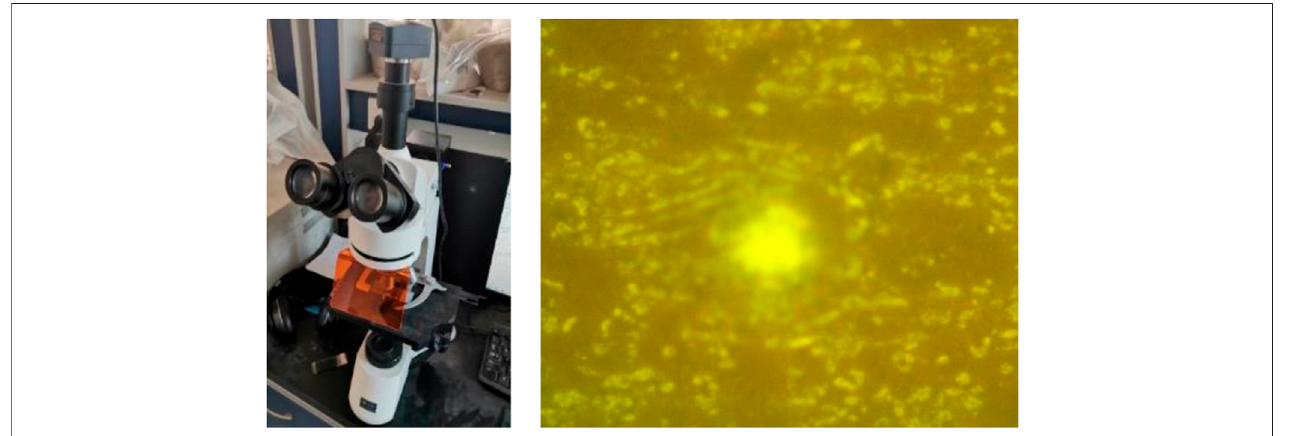
FIGURE 2 | Fluorescence microscope and fl uorescence